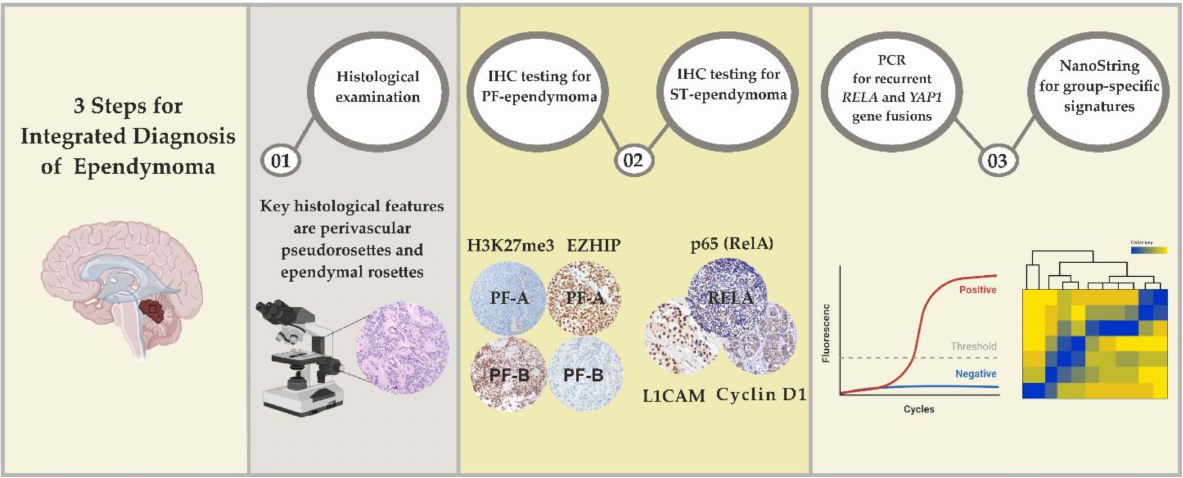
Figure 2. The integrated approach for molecular group determination applied to ependymal